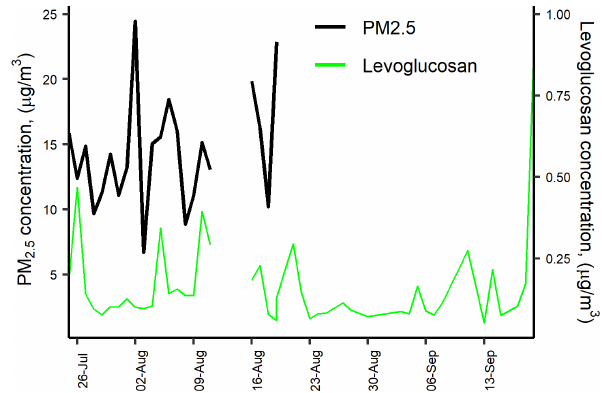
Figure 3. Daily variation in the levoglucosan and PM 2 . 5 concen- tration at